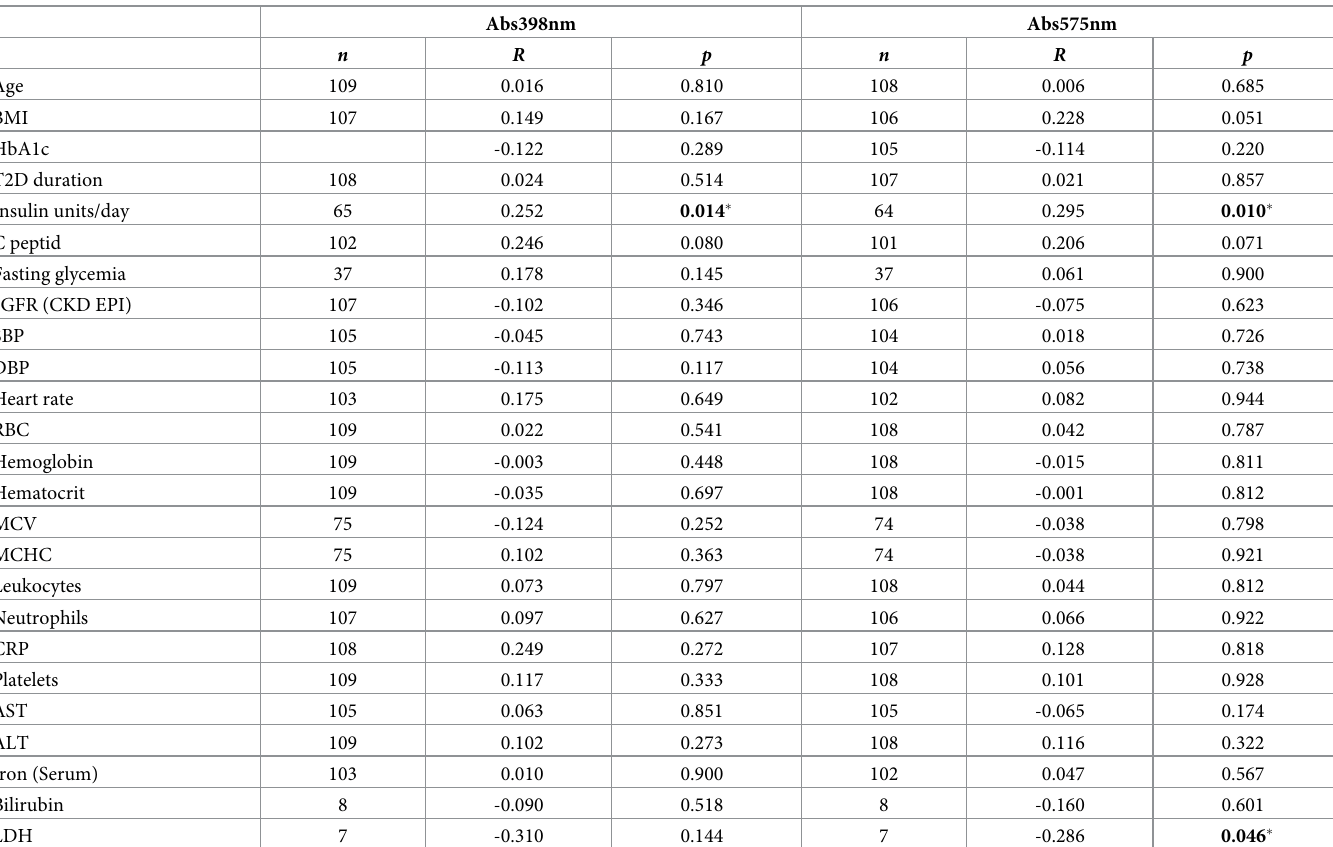
Table 1. Correlations between IVH markers and baseline data in T2D patients after adjustment for age and